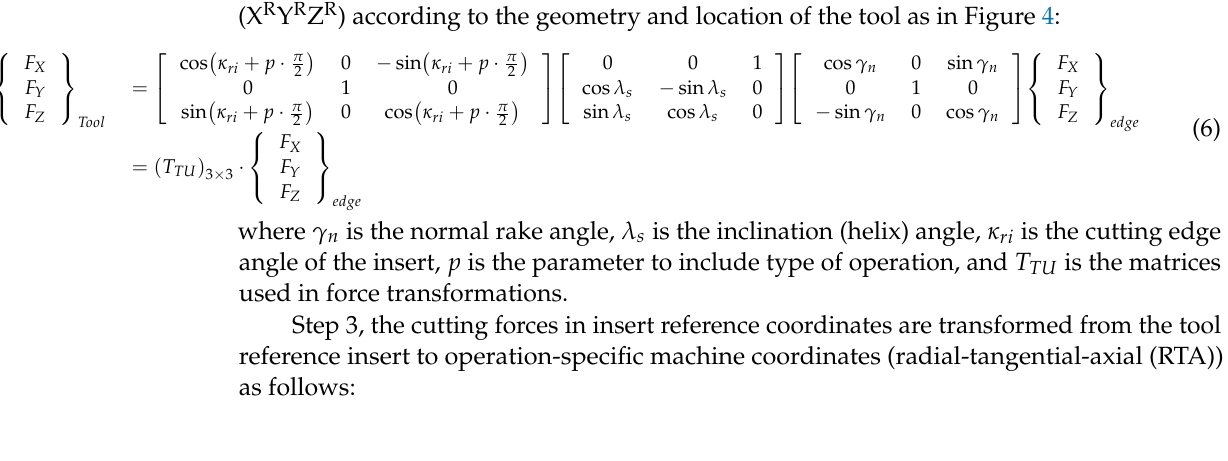
Figure 4. Mechanics of oblique cutting.